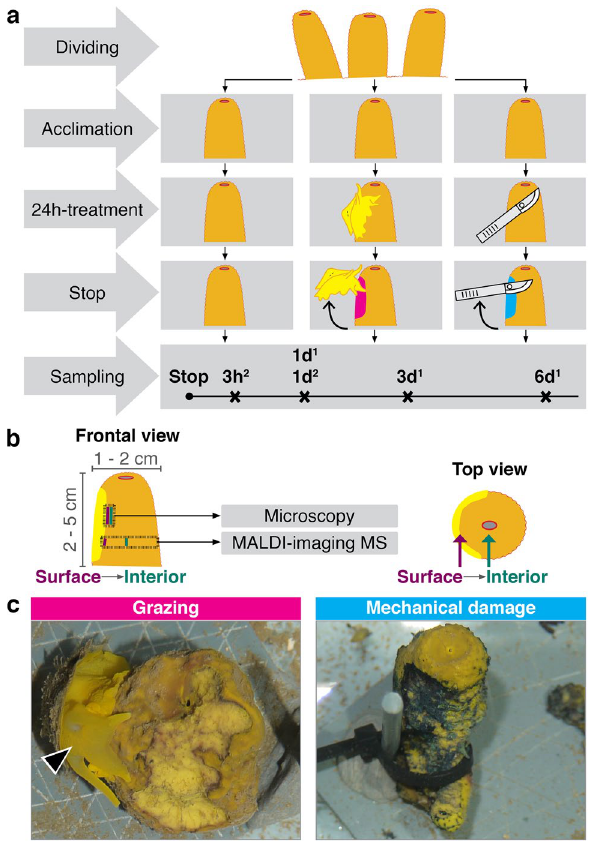
Figure 1. Experimental design. ( a ) Each sponge individual was divided into three specimens that were randomly assigned to either control (left panels), grazing (middle panels), or mechanical damage (right panels) treatment. Treatment was applied for 24 h. We performed consecutive experiments to collect samples at different time points: 3 h, 1 day, 3 days, and 6 days post-treatment. Superscript number 1 and 2 denotes experiments performed in 2016 and 2017, respectively. ( b ) Size of the sponges and sampling area for microscopy and MALDI-imaging MS. The corresponding surface (purple) and the interior (dark green) of sponge samples and the wound (yellow) are also shown. Histological cross-sections of the sponge tissues (a view from the top) were collected for MALDI-imaging MS analysis. ( c ) Wound by T. perversa (arrowhead, left panel) and by mechanical damage (right panel). The figure layout and figure panels ( a,b) were generated in Scribus (version 1.5.5., URL: http://www.scrib